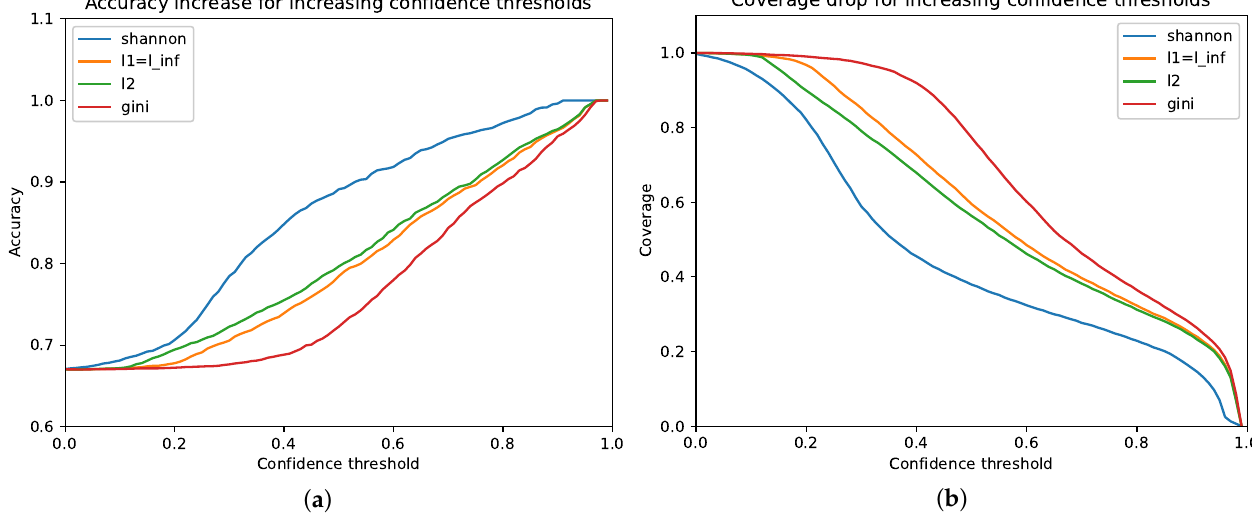
Figure 4. Accuracy ( a ) and coverage ( b ) curves for evaluated